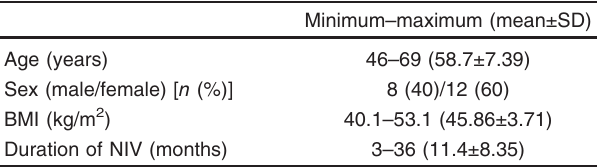
Table 1 Sociodemographic and duration of noninvasive ventilation in the studied